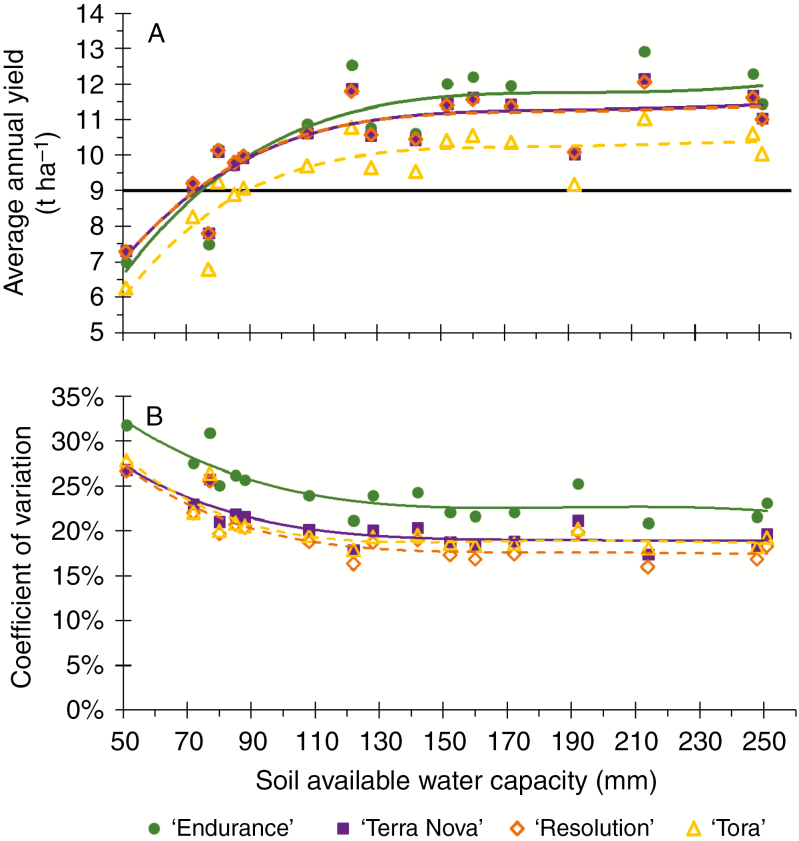
Average simulated annual yields (A) and associated coefficients of variation (B) for willow cultivars ‘Endurance’ (green filled circles), ‘Terra Nova’ (purple filled squares), ‘Resolution’ (orange open diamonds) and ‘Tora’ (yellow open triangles) for 2-year growth cycle management between 1966 and 1988 (started in 1965) for two weather stations in the SE of the UK regarding the SAWC of 17 soils. An economic threshold of 9 t ha−1, above which profits are made, is represented by a black line and coloured lines represent polynomial regressions of the genotypic values.